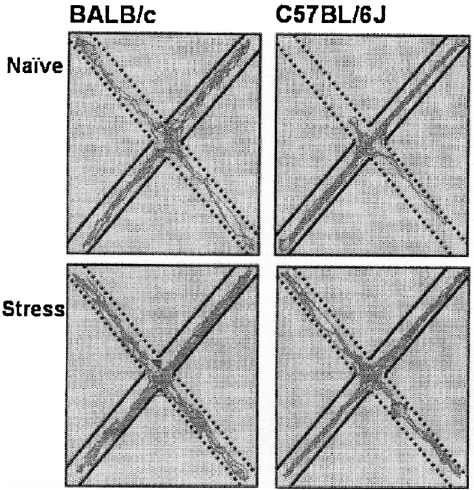
Figure 4. Representative walking patterns of BALB/c (left) and C57BL/6J mice (right) in the elevated plus maze. The dotted lines show the open arms, the straight lines the closed arms.